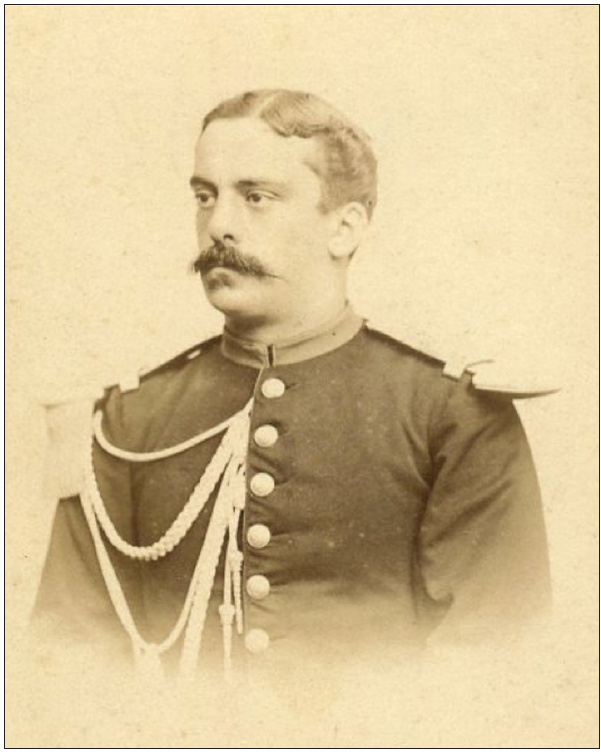
Fig. 5 : Georges Castelnau in uniform, c. 1870–71, Hervé Oléon